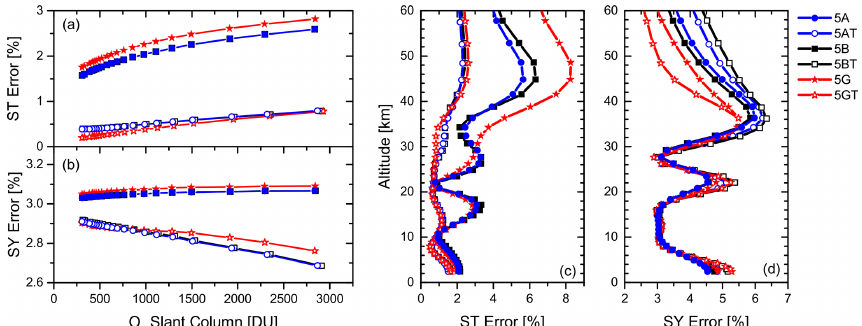
Figure 2. (a) Estimated total statistical (ST) and (b) systematic (SY) errors (%) for O 3 TCs retrieved from the 5A and 5AT, 5B and 5BT, and 5G and 5GT set-ups as a function of O 3 slant column (SC) (DU) for measurements taken on 31 August 2007 from solar zenith angles (SZAs) between 84 ◦ ( ∼ 07:00UT) and 21 ◦ ( ∼ 13:30UT). (c) Example of estimated total statistical (ST) and (d) systematic (SY) error profiles (%) for the same set-ups for the spectrum taken on 31 August 2007 at a SZA of ∼ 50 ◦ and an O 3 SC of 390DU. The total errors are computed as the square root of the quadratic sum of all ST and SY error sources